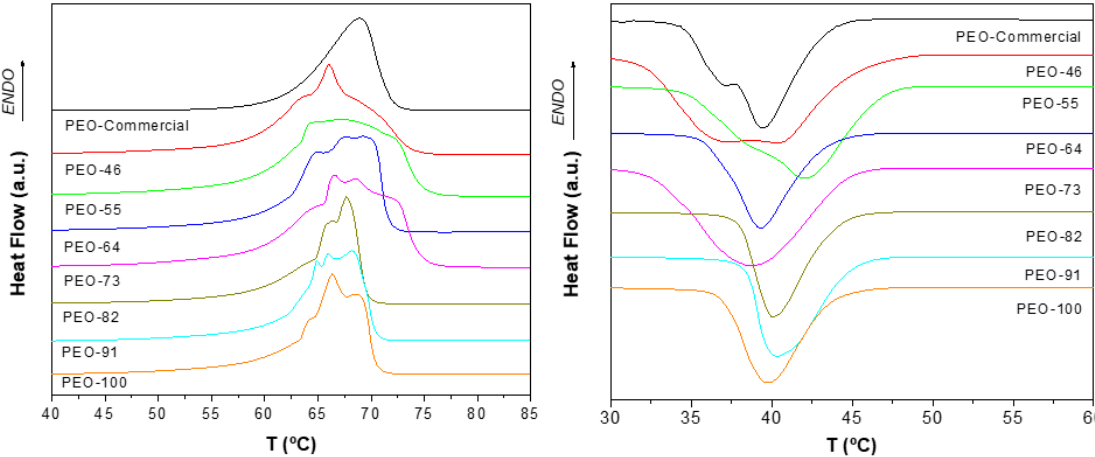
Figure 4. DSC thermograms of blow spun PEO at different compositions Chl:Ac. First heating scan ( left ) and subsequent cooling scan ( right ). Table 3. Data obtained from DSC curves corresponding to: (a) melting transition and (b) crystalliza- tion